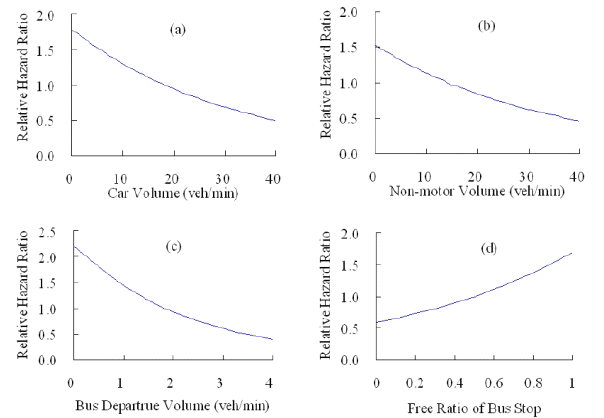
Fig. 3. Relative hazard indexes for four